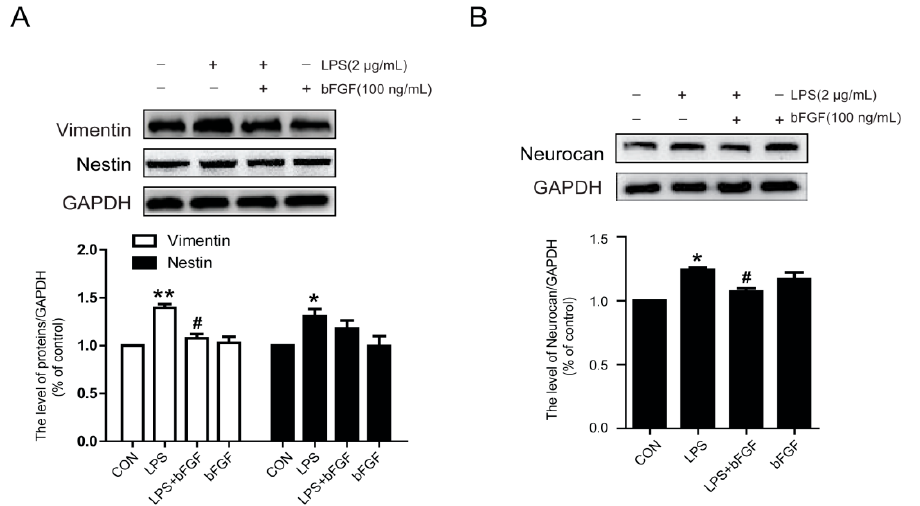
Figure 4. Effect of bFGF on vimentin, nestin and neurocan in astrocytes stimulated by LPS. We measured additional markers of activated astrocytes. ( A ) Western blot of vimentin, nestin, and densitometric analyses; ( B ) Western blot of neurocan and densitometric analyses. * p < 0.05, ** p < 0.01 versus CON, # p < 0.05 versus LPS. All results represent at least three independent experiments.